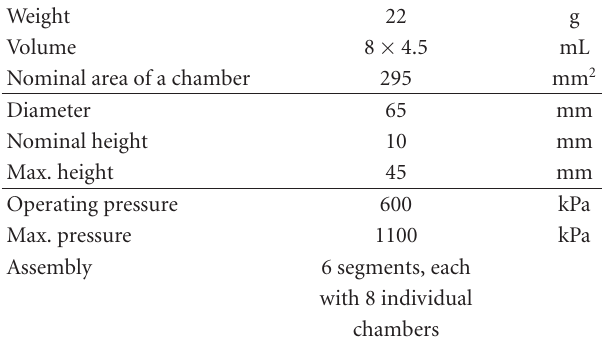
Table 3: Data sheet of the 2D